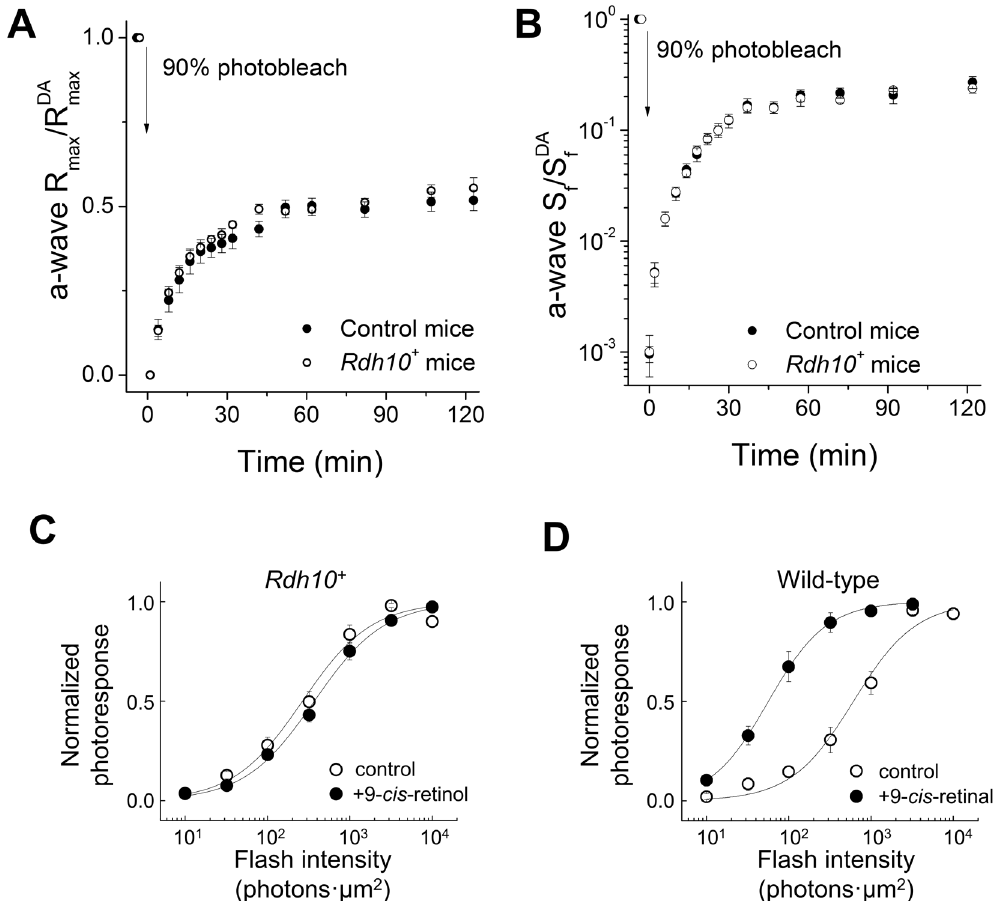
Figure 9. Ectopic expression of RDH10 does not enable rods to dark adapt faster or to oxidize cis -retinol for pigment regeneration. ( A and B ) Normalized rod scotopic a-wave maximal response (R max /R maxDA ; A ) or sensitivity (S f /S fDA ; B ) recovery following a 90% pigment photobleach in control (n = 9, filled symbols) and Rdh10 + (n = 9, open symbols) mice measured by in vivo ERG recordings. ( C and D ) Normalized intensity- response curves determined by single-cell suction recordings from ( C ) transgenic Rdh10 + rods incubated in control solution (n = 13, open symbols) or in 100 µ M 9- cis -retinol solution (n = 14, filled symbols), or from ( D ) wild-type rods incubated in control solution (n = 6, open symbols) or in 100 µ M 9- cis -retinal solution (n = 11, filled symbols) following 50% pigment